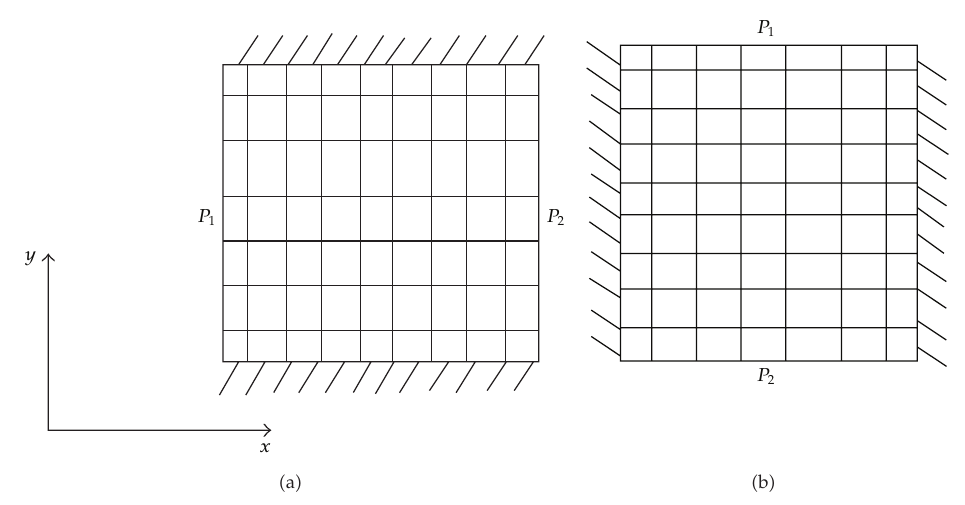
Figure 4: The boundary condition for each coarse cell.